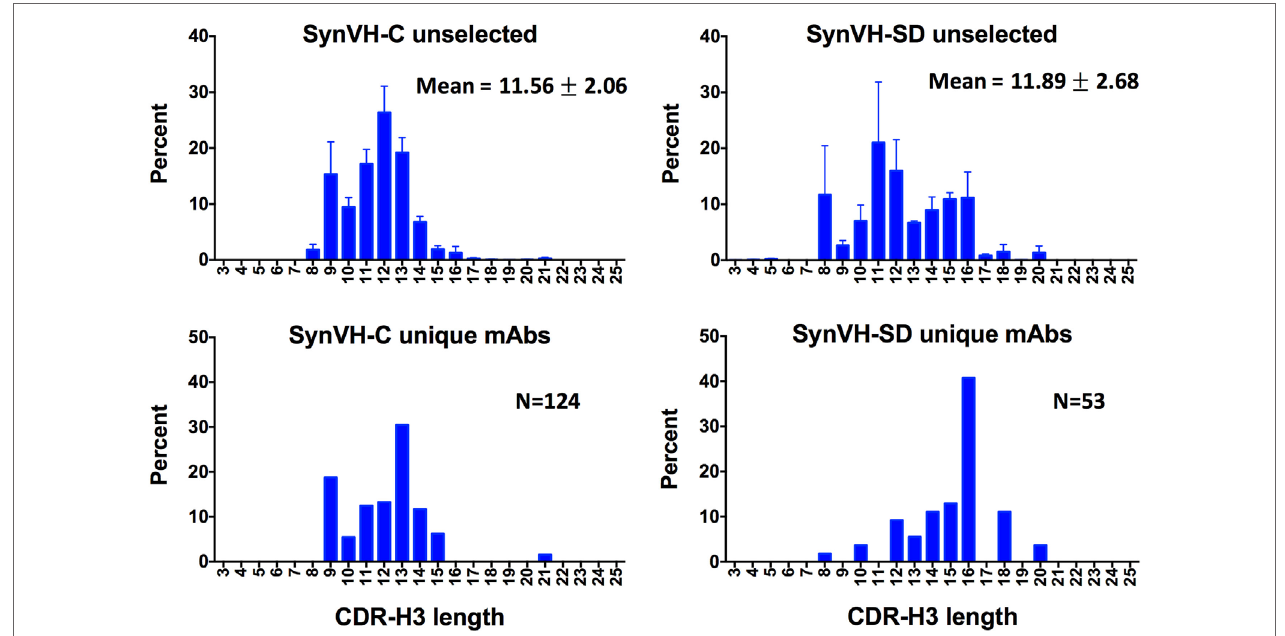
FigUre 3 | CDR-H3 lengths show a broader distribution in SynVH-SD. CDR-H3 lengths from all of the sequences (“unselected,” top two panels) were calculated based on IMGT positions 105–117 and plotted based on the frequency of each length out of all sequences with a clear CDR-H3 ( N = 3,099,355 for SynVH-C, N = 1,050,398 for SynVH-SD). Error bars indicate bird-to-bird variation; SynVH-C, N = 6 birds, SynVH-SD, N = 3 birds. Mean and SD are given. Lower two panels show CDR-H3 lengths of the progranulin-specific mAbs.